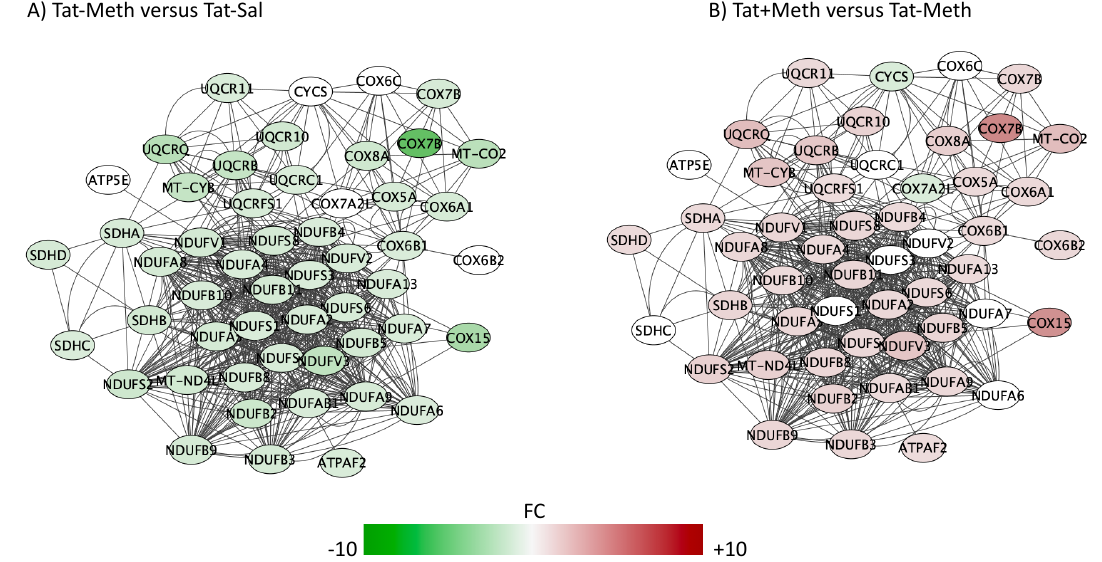
Figure 5. Oxidative phosphorylation pathway. Genes with overlapping actions observed in ( A ) Tat − / Meth vs. Tat − / Sal and in ( B ) Tat +/ Meth vs. Tat − / Meth and assigned to oxidative phosphorylation were loaded into Cytoscape via Genemania; significant changes associated to assigned comparisons ( p < 0.01) were visualized by loading the node attributes table. Tat − / Meth vs. Tat − / Sal p = 1.56 × 10 − 14 and Tat +/ Meth vs. Tat − / Meth p = 4.50 × 10 − 12 , with 73.9% and 67.0% overlap,